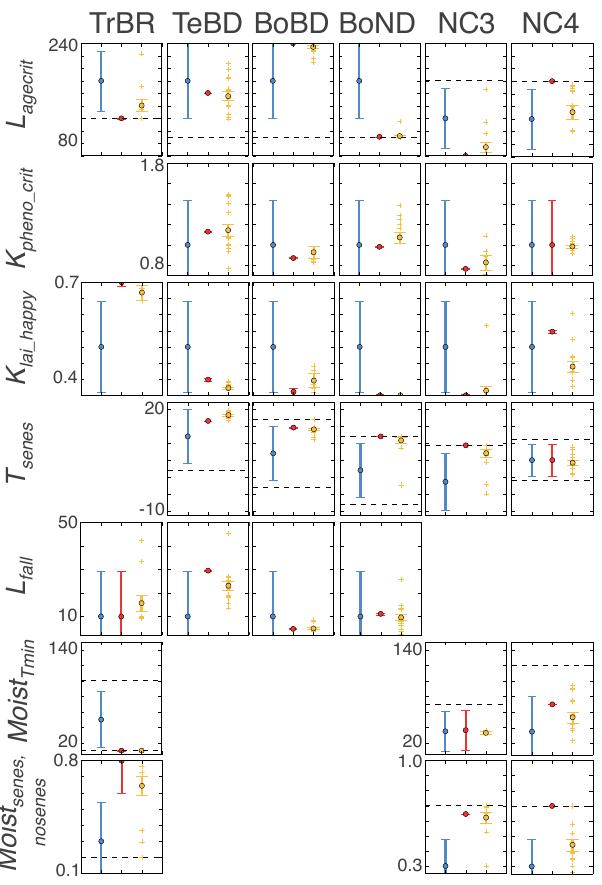
Figure 7. The prior (blue), MS posterior (red) and SS posterior (or- ange) parameter values (circles) and uncertainty (error bars – vari- ance calculated in Eq. 3) for each parameter and each PFT. For the SS optimisations the circle and error bars represent the mean and standard error of the mean of all sites, and the crosses give the posterior values for each site. Refer to Table 1 for a description of the PFTs and Fig. 1 and Appendix A for a description of each parameter. The y axis range represents the maximum upper and lower bounds for each parameter across all PFTs, and the horizontal dashed lines represent the parameter range for each individual PFT. Figure 8. The difference (posterior – prior) of the simulated annual